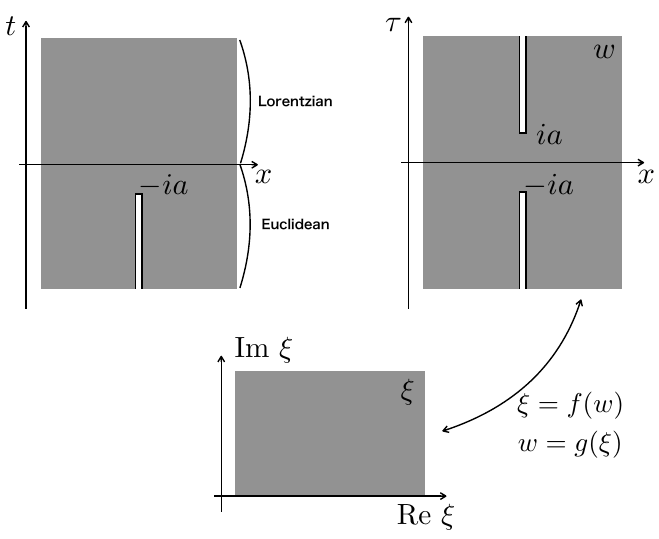
Figure 3 . The left (cid:12)gure shows how to realize a single joining quench using path integral in a (1+1)d CFT. The right (cid:12)gure shows the corresponding Euclidean setup. It can be mapped into an upper half plane as showed in the lower (cid:12)gure using (2.22) or